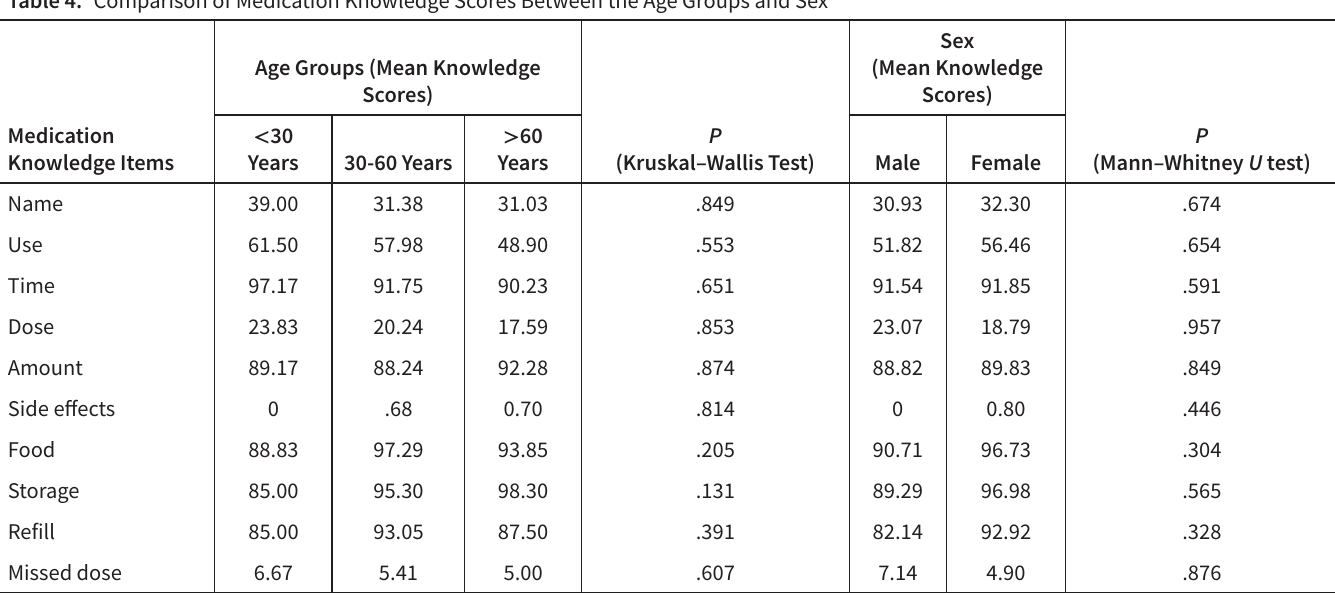
Table 4. Comparison of Medication Knowledge Scores Between the Age Groups and Sex